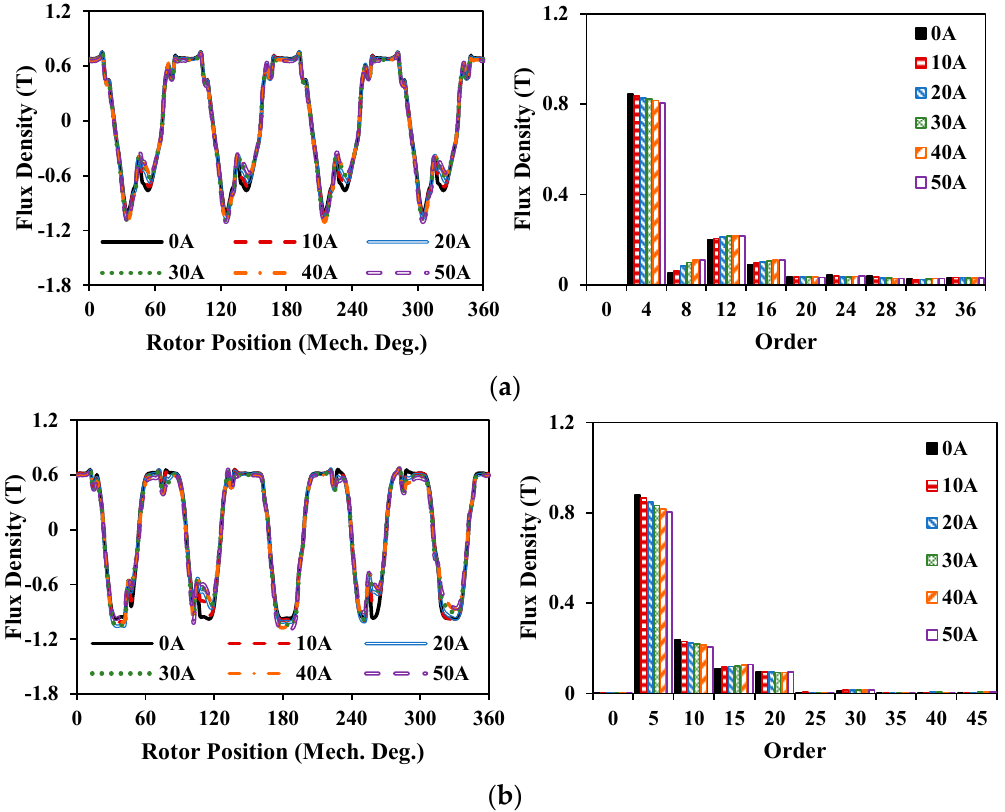
Figure 26. Flux densities and spectra of two PSCPPM machines. ( a ) 12s8p-PSCPPM. ( b ) 12s10p- PSCPPM.